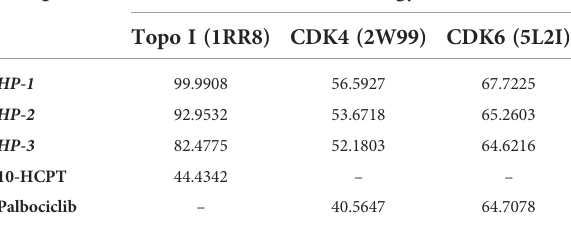
TABLE 1 Docking simulation results of HP-1 , HP-2 , and HP-3 , 10- HCPT, and palbociclib with 1RR8, 2W99, and 5L2I.